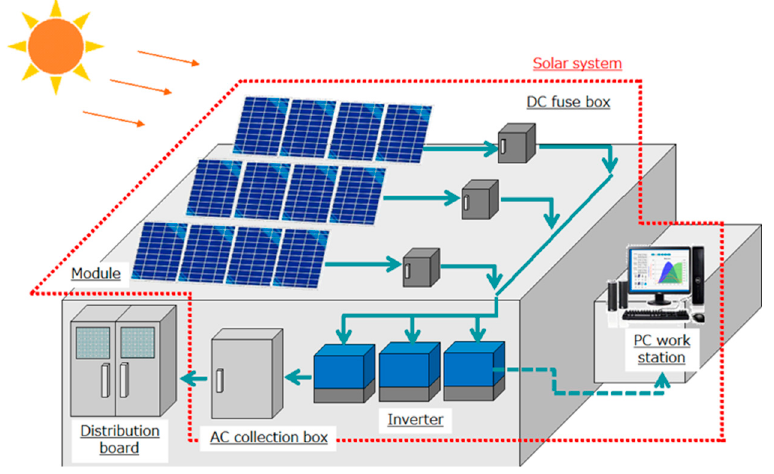
Figure 1. Solar power system [3].